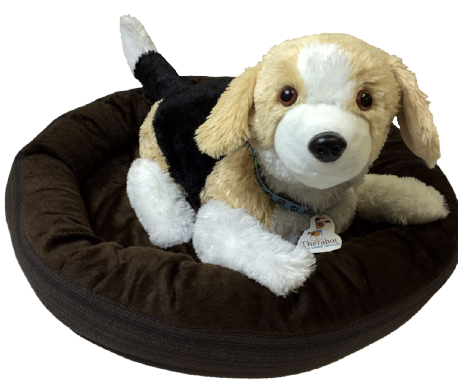
Figure 1: The therapeutic robotic dog: Therabot TM